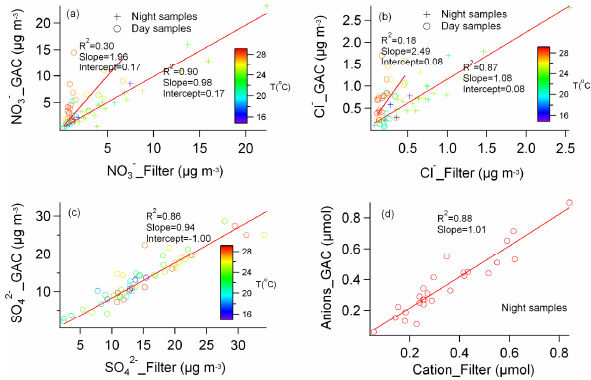
Fig. 12. Correlations of (a) NO − ; (b) Cl − and (c) SO 2 − between 3 4 Fig.12. Correlations of (a) NO 3- ; (b) Cl - and (c) SO 42- between the GAC-IC and filter the GAC-IC and filter measurement and (d) correlation between measurement and (d) correlation between 2SO 42– + NO 3– + Cl – measured by the 2SO 2 − + NO − + Cl − measured by the GAC-IC system and NH + 4 3 4 GAC-IC system and NH 4+ of night samples measured by the filter. of night samples measured by the filter.